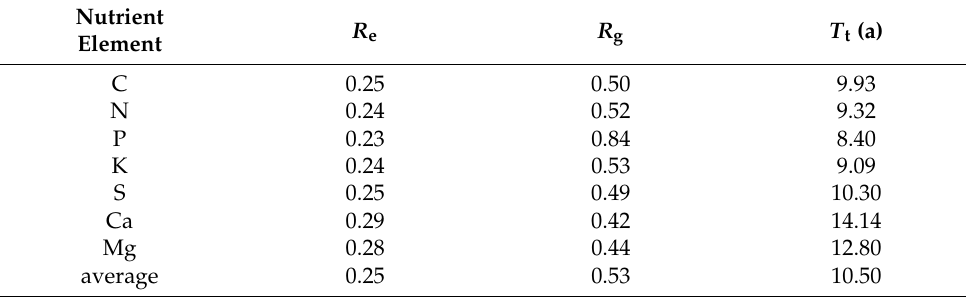
Table 8. Biological cycle of different